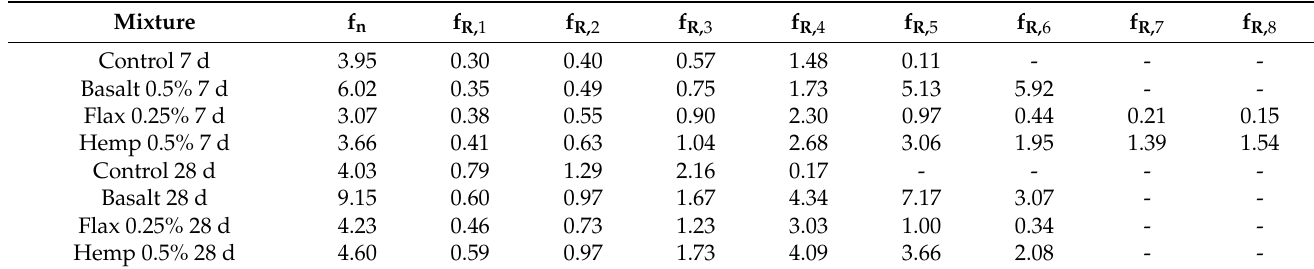
Table 10. Flexural tensile strength (f n ) and (f R,j ) [MPa] obtained from the optimised mixes.